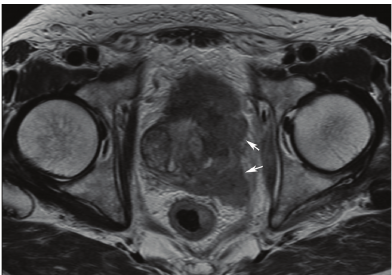
Figure 2: T2-weighted MR imaging demonstrated a tumor origi- nating from the left peripheral zone of the prostate (arrow).